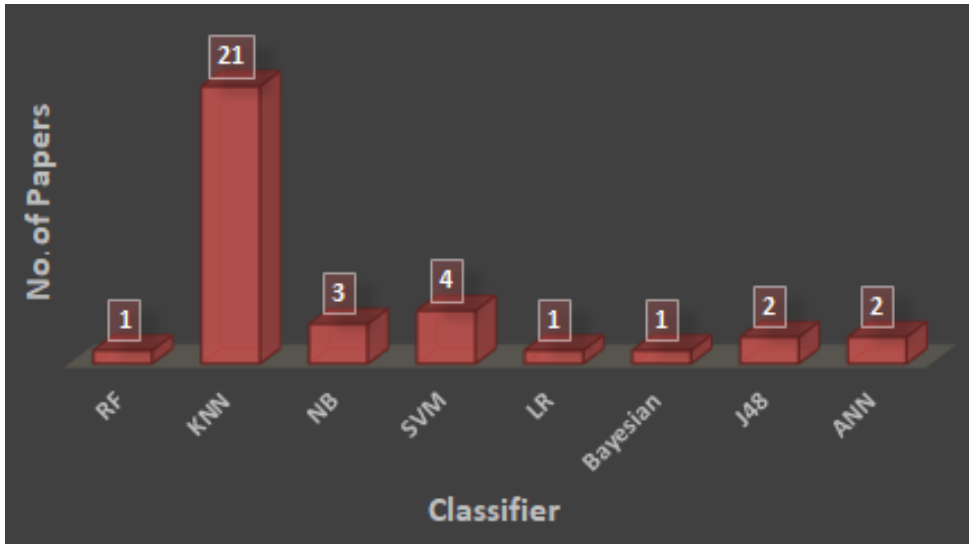
Figure 6. Number of papers vs.